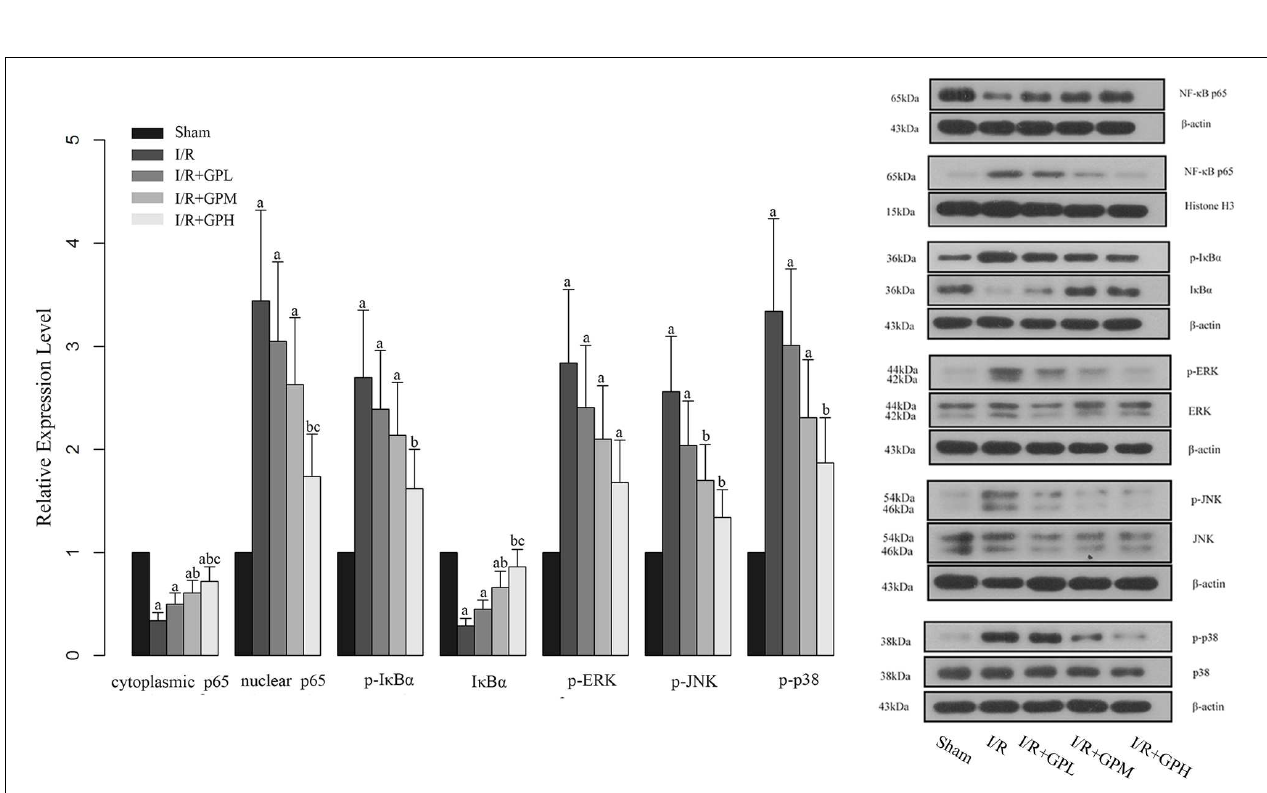
FIGURE 5 | Effect of GP treatment on the expression of molecules involved in the MAPK mediated NF- κ B activation in I/R injured rats. a, significantly different from sham group, P < 0.05. b, significantly different from I/R group, P < 0.05. c, significantly different from I/R + GPL group, P < 0.05.